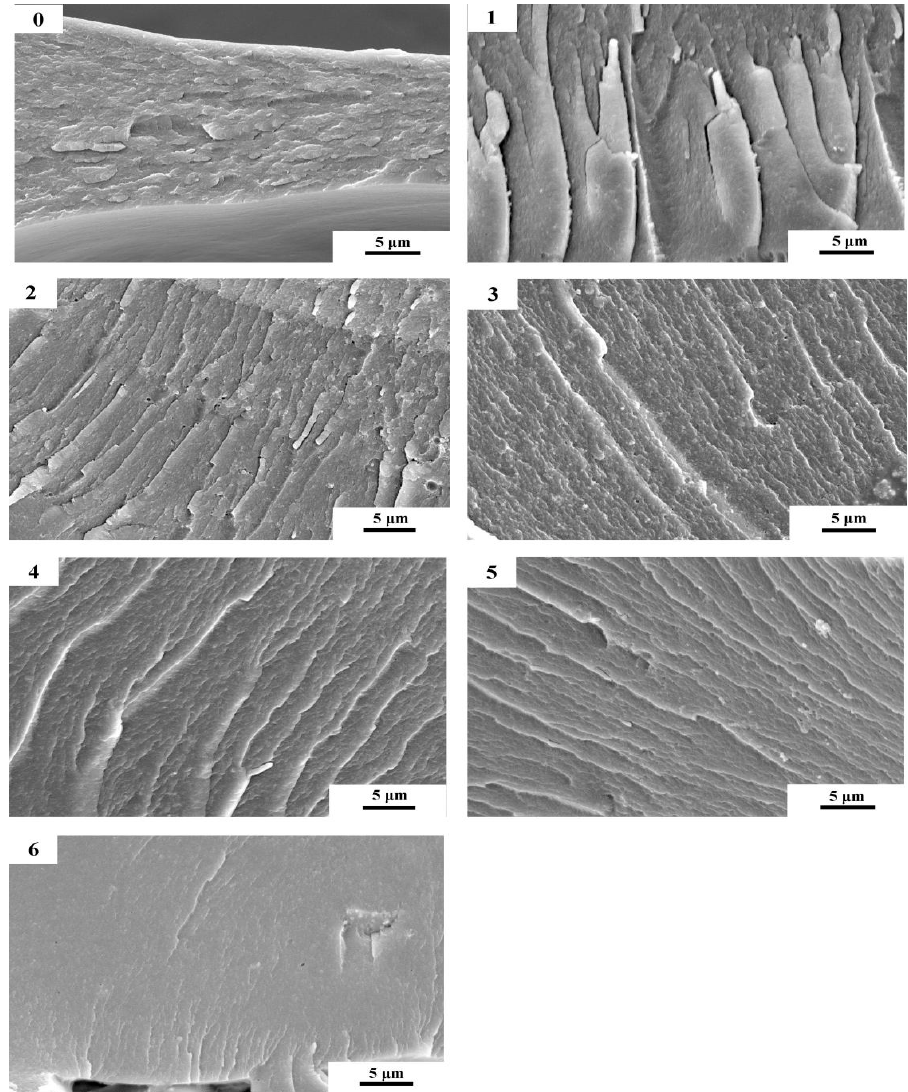
Figure 7. Fracture surface micrographs of the different cured adhesive samples: 0 (12 wt% SPI), 1 (18 wt% SPI/bromelain), 2 (18 wt% SPI/bromelain/3 wt% TGA), 3 (18 wt% SPI/bromelain /6 wt% TGA), 4 (18 wt% SPI/bromelain/9 wt% TGA), 5 (18 wt% SPI/bromelain/12 wt% TGA), and 6 (18 wt% SPI/9 wt% TGA).